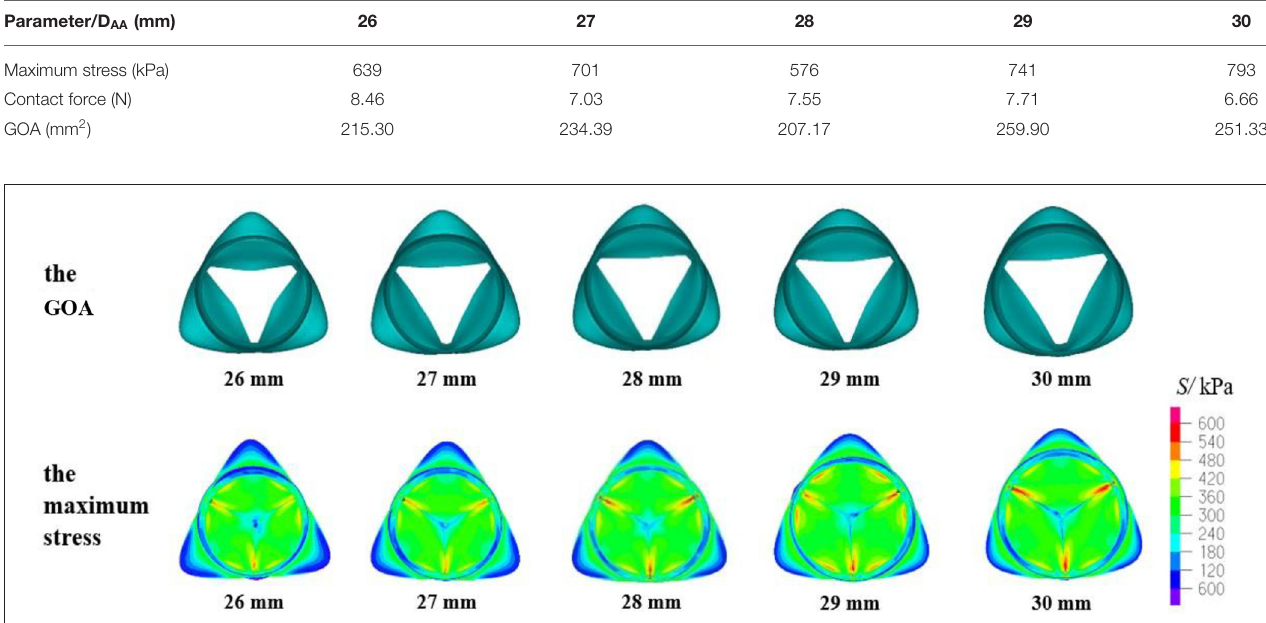
FIGURE 8 | GOA of the valve and maximum stress distribution of the model with H V = 14.5mm and D AA of